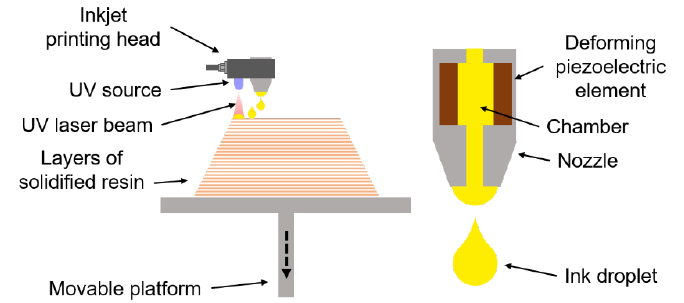
Figure 9. Schematic of a typical DOD printing method.